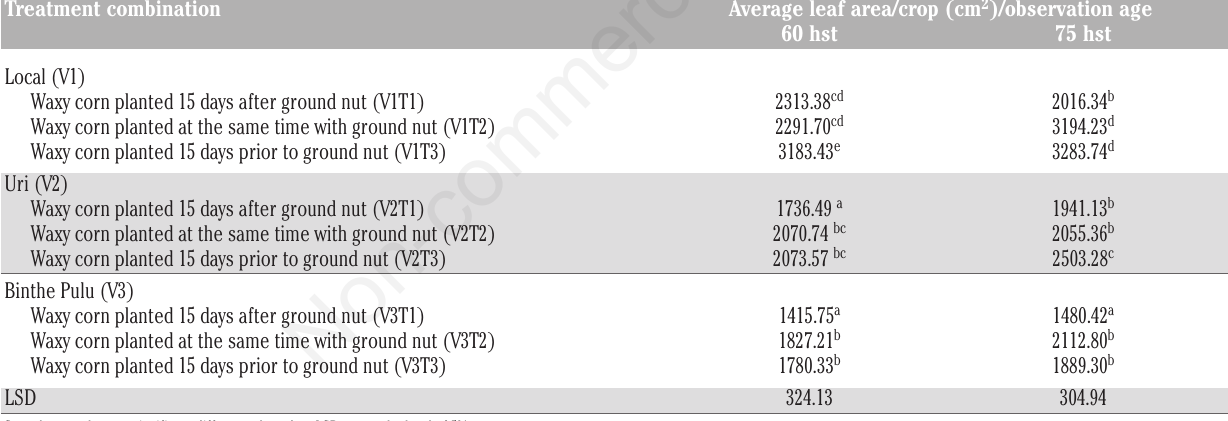
Table 1. Average leaf area per crop (cm 2 ) as the result of interaction between variety and corn planting date. Treatment combination